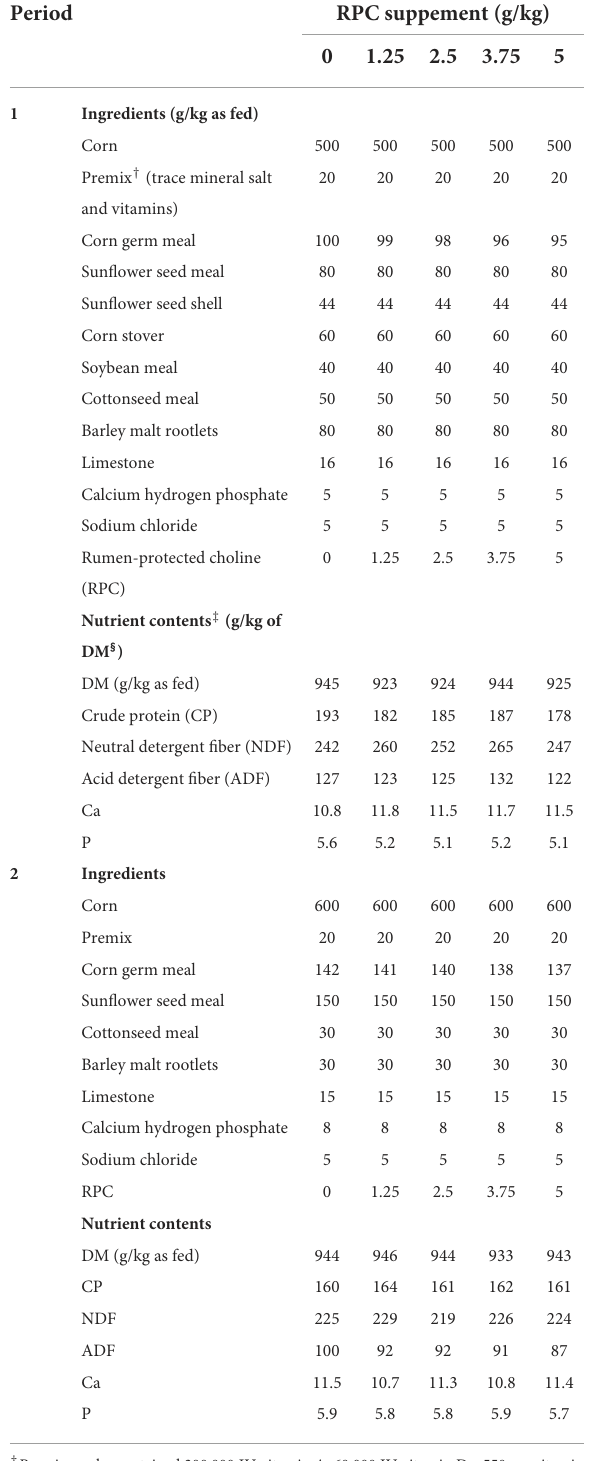
TABLE 1 Ingredients and nutrient contents of experimental